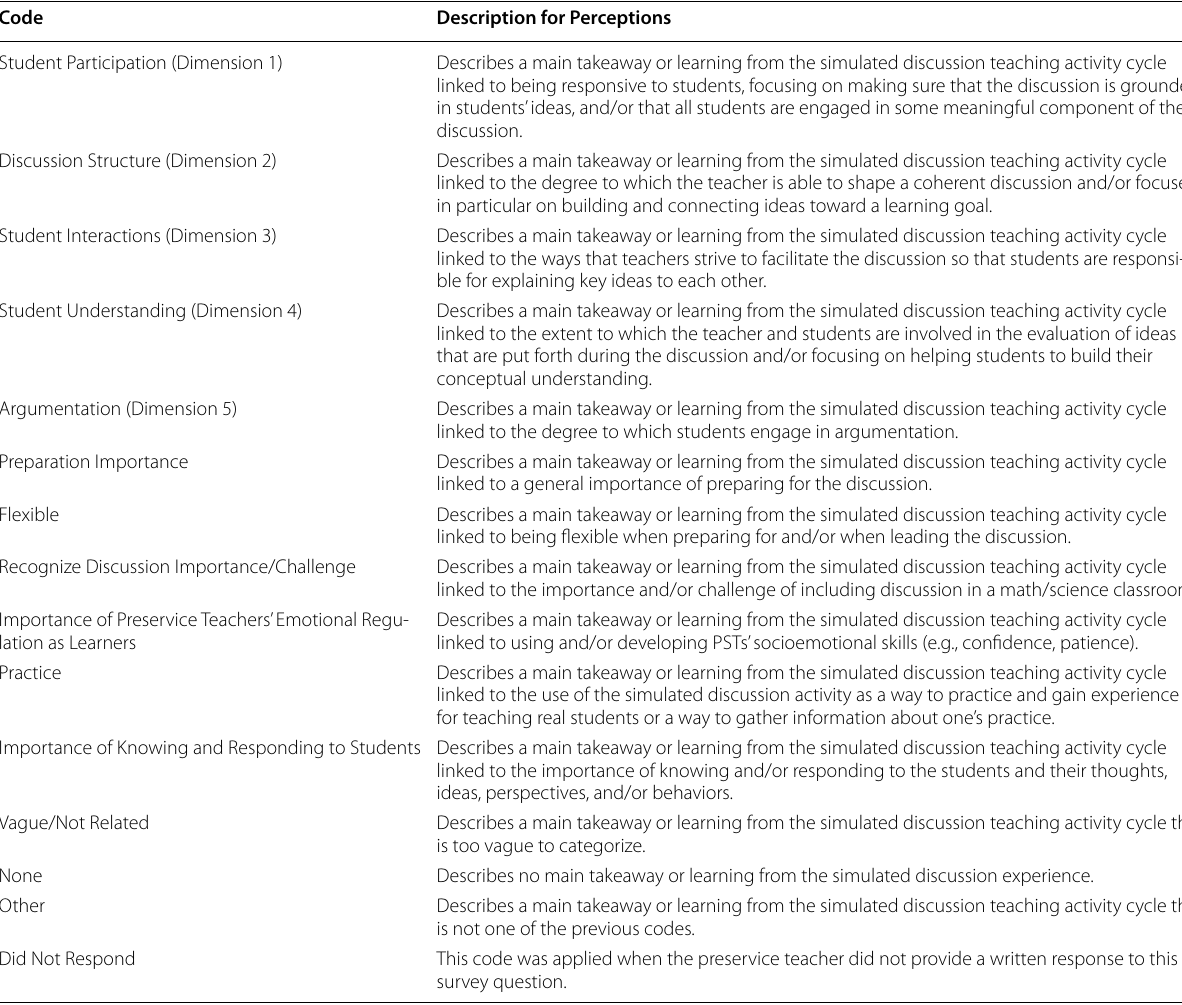
Table 2 Coding for Perceptions of Learning from the Simulated Teaching Experience Code Description for Perceptions Student Participation (Dimension